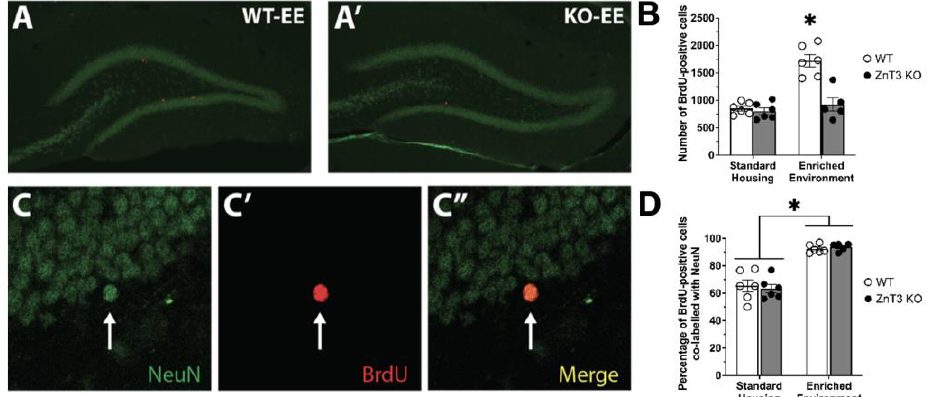
Figure 2. Cell survival in the hippocampus of WT and ZnT3 KO mice exposed to SH or EE ( n = 23). Representative photomicrographs of BrdU-immunopositive cells (red) in the granule cell layer of a ( A ) WT and ( A’ ) ZnT3 KO mouse housed in EE. ( B ) EE exposure significantly increased the survival of proliferating cells in WT mice but had no effect on ZnT3 KO mice. ( C ) Confocal microscopic images showing cells expressing the mature neuronal marker NeuN (green), with a BrdU-positive cell in the same plane (( C’ ), red). ( C” ) The channels are merged to show co-localisation. ( D ) Exposure to EE increased the percentage of BrdU-positive cells co-expressing NeuN in both WT and ZnT3 KO mice. Error bars represent ± standard error of the mean. * indicates p < 0.001.